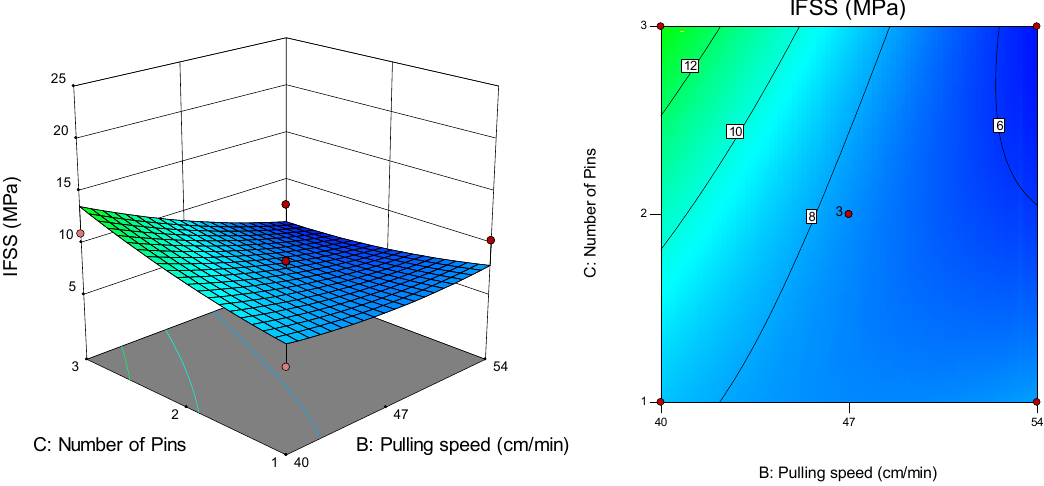
Figure 13. Interaction effect between pulling speed and number of pins on IFSS.